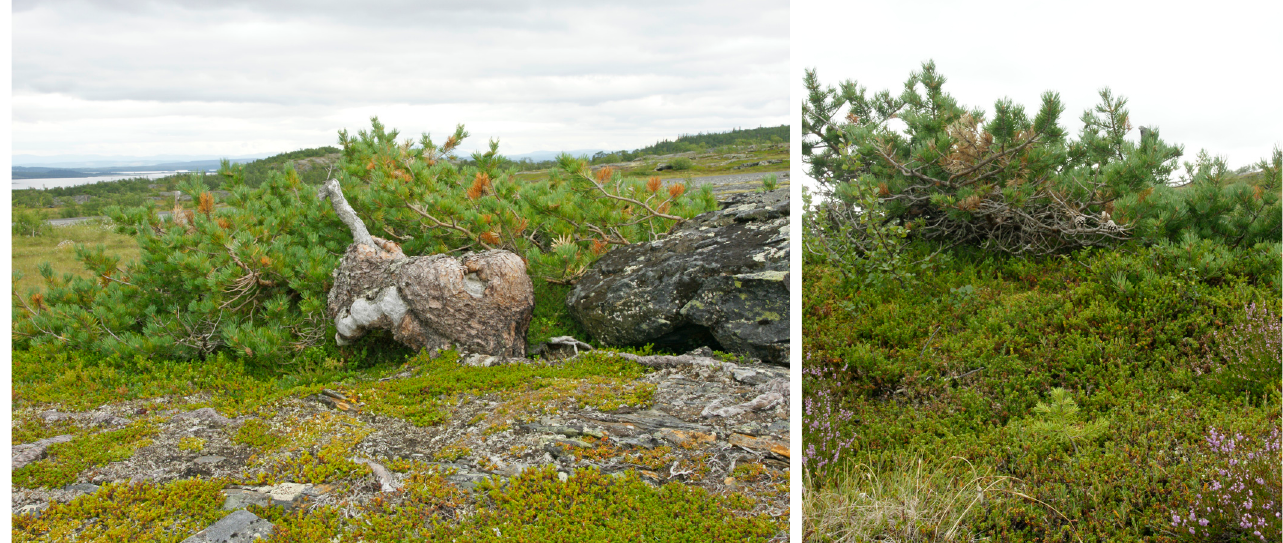
Figure 30: Left. Pine krummholz, more than 400 years old, growing in an open and wind-exposed spot in the lower subalpi- ne birch belt. During the last decade, a slight tendency for more upright growth can be discerned. Right. At the same time, offspring has been produced leeward of the old and stunted pine. Mt. Storsnasen, 650 m a.s.l. 15 August